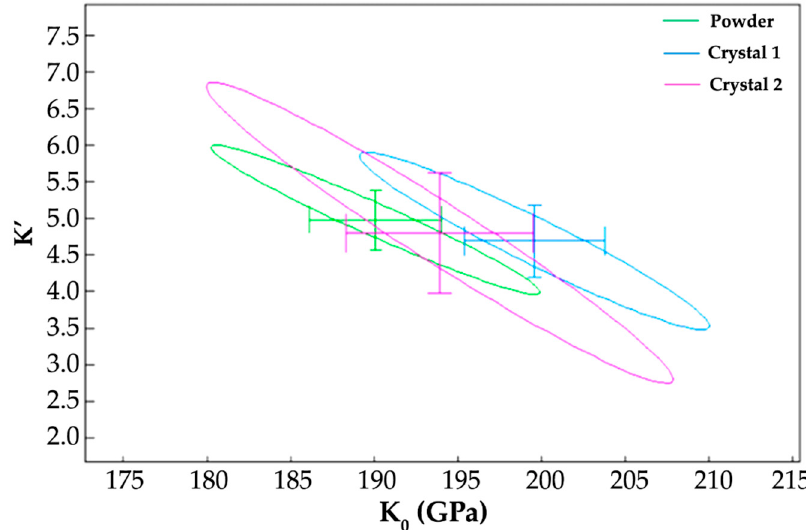
Figure 5. The confidence ellipses from all our data on Ni 3 P are drawn at a 95.4% level, indicating that all calculated K 0 and K’ values from this study are consistent.